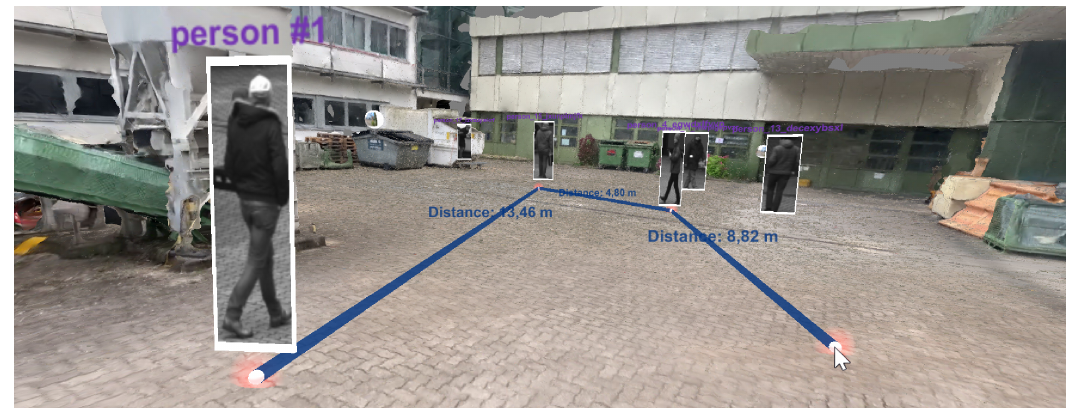
Figure 27. Interactive tool for measuring distances and object sizes in the